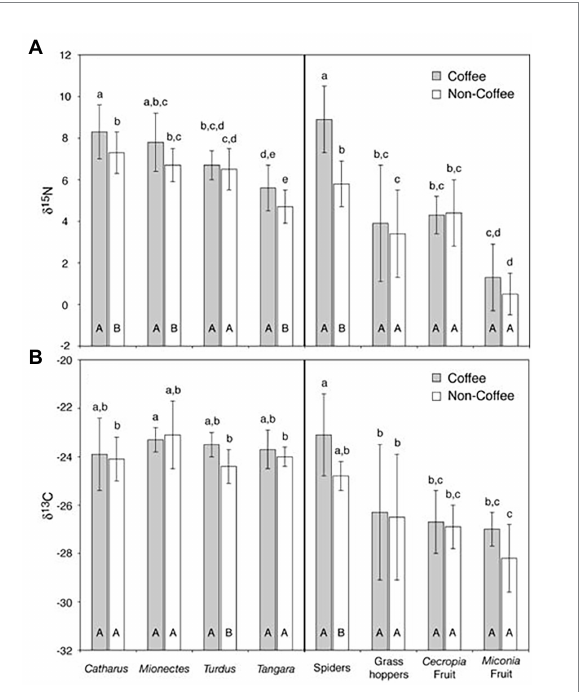
FIGURE 3 Mean δ 15 N (A) and δ 13 C (B) values of the four bird species and common dietary resources collected in coffee versus forested non- coffee habitats. Error bars denote one standard deviation from the mean. Refer to Table 1 for the sample sizes. Lowercase letters signify results of a one-way ANOVA comparing mean values among prey types and uppercase letters signify ANOVA results for the comparisons of a single prey type between